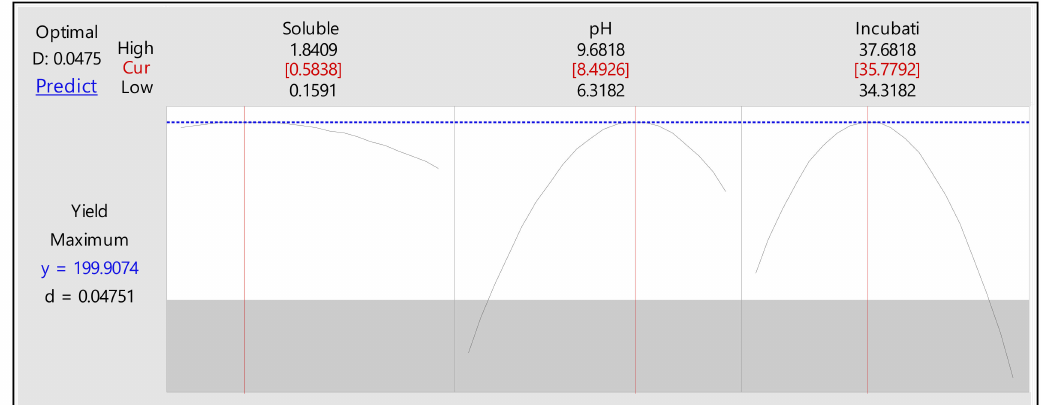
Figure 5. Response optimizer plot illustrating the optimum levels of variables for maximum amylase production by Bacillus sp.